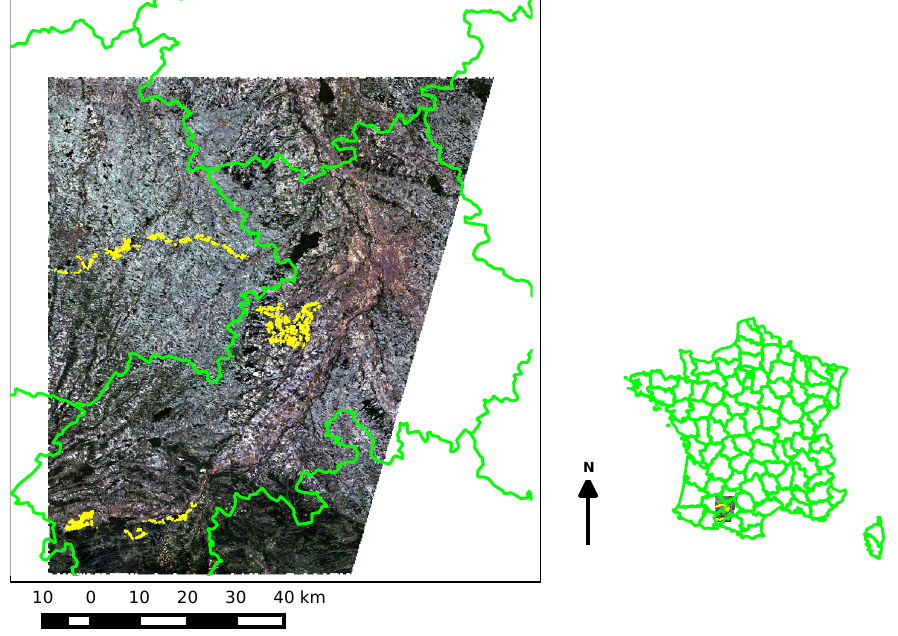
Figure 1. Study site located in the south-west of France. Field survey data is displayed in yellow on top of a Landsat8